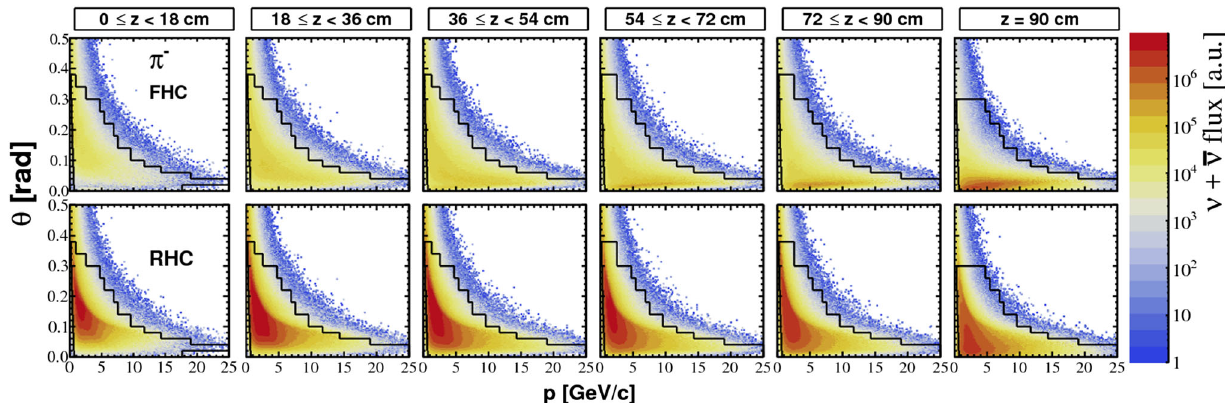
spaceforthereversehorncurrentconfiguration.TheNA61/SHINEcov- erage from the 2010 replica target measurement is overlaid on top of the plots